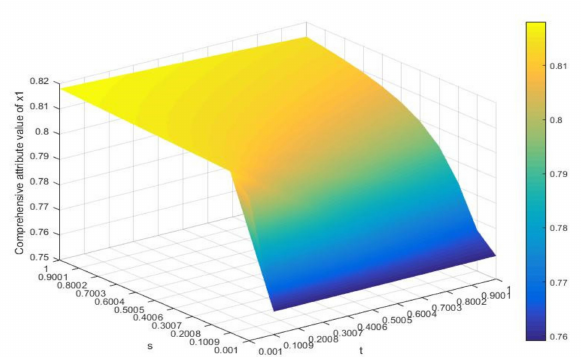
Figure 3. Comprehensive attribute values of x 1 obtained by the TPGWHM ( t , s ∈ [ 0.001,1 ]